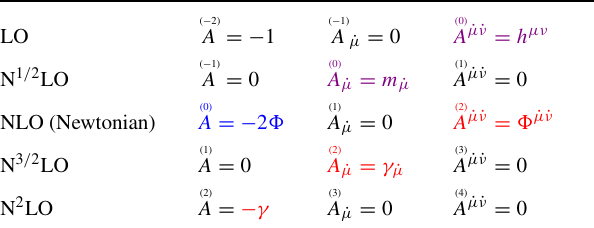
Table 2 In this table all gravitational potentials appearing up to next to next to leading order (N 2 LO) in the large c expansion are listed. In the previous literature on this expansion [1–4] most of these potentials have been assumed to vanish, as indicated in the table. The NLO level can be identified as the Newtonian level, since (cid:13) (in blue) is